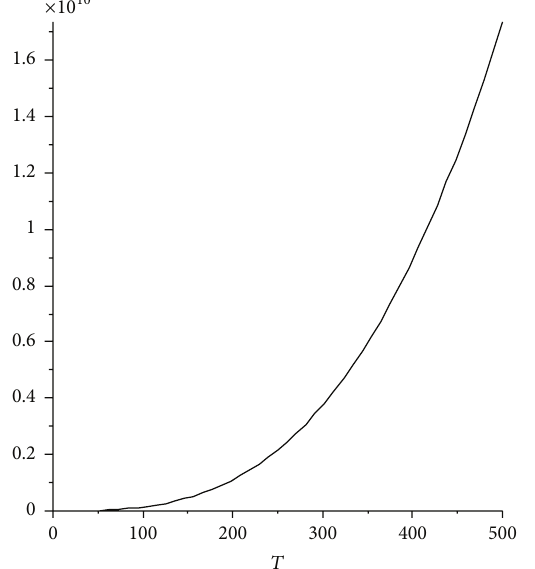
Figure 3: Plot of the jet-quenching parameter in terms of the temperature for small black hole charge. We fixed the parameters as 𝛼 󸀠 = 0.5 , 𝜆 = 6𝜋 . In that case three different cases of one-, two-, and three-charged black holes have similar